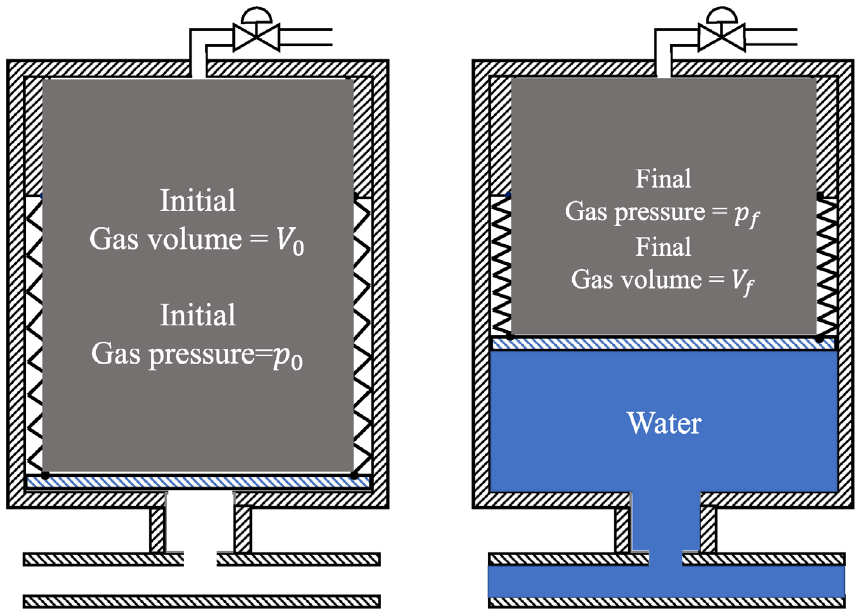
Figure 8. Operation procedure of the gas resonator. The gas-cavity is is initially fi lled with air at absolute pressure p 0 by using a gas inlet valve on top of the resonator without any static pressure from fl uid circuit, hence gas-cavity has initial volume V 0 . Once the pressure in the water circuit is increased up to the fi nal pressure p f the volume of the gas-cavity reduces from V 0 to V f